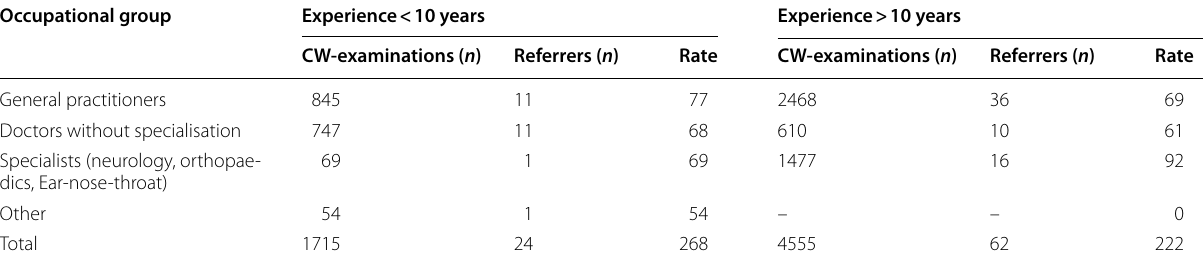
Table 2 Referral practice by